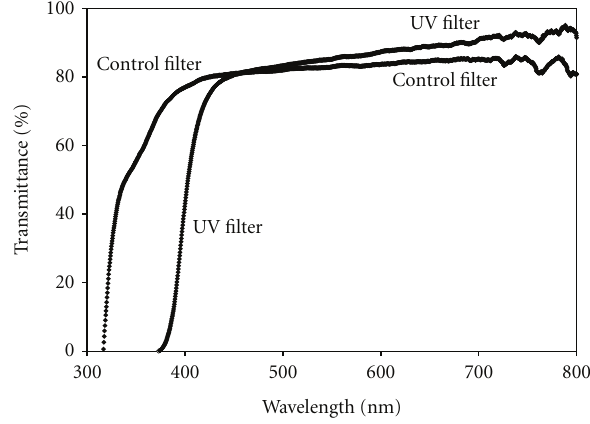
Figure 2: Transmission spectra of the control and UV filters (lines marked in graph) as measured using the USB-2000 (Ocean Optics).